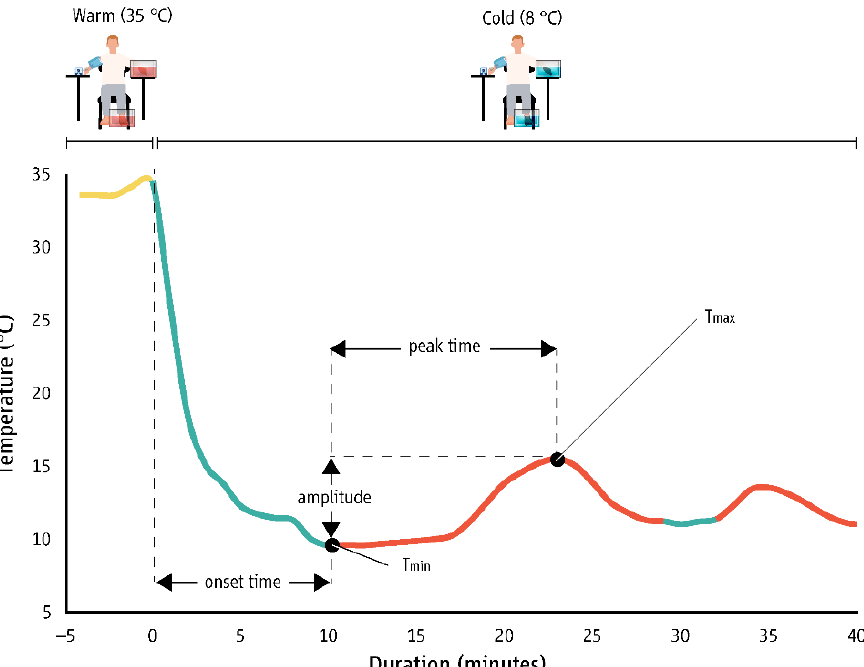
Figure 2. Representative data for two cold-induced vasodilation (CIVD) reactions (red color) in the index finger of a male participant. Onset time (green color) corresponds to the time needed to reach minimum temperature (T min ) prior to the onset of CIVD. Amplitude represents the difference between T min and the highest temperature during the CIVD (T max ). Peak time corresponds to the time interval between T min and T max